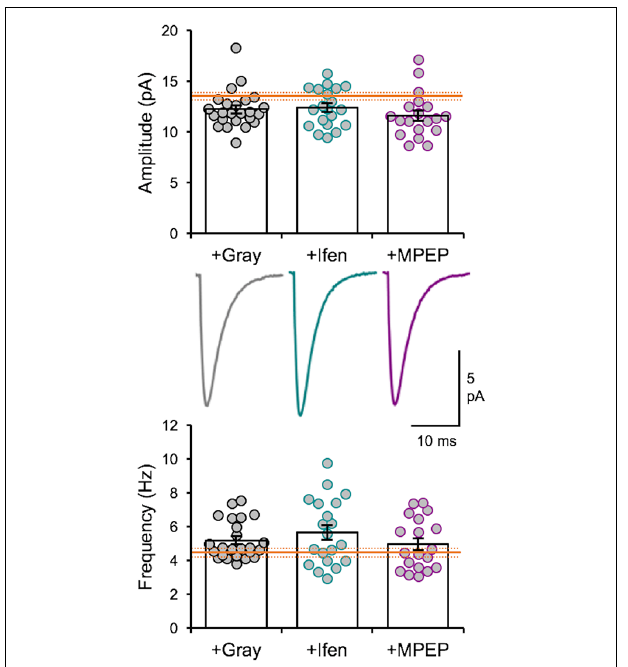
FIGURE 6 | The same naturalistic pattern stimulation yields distinct synaptic changes dependent on prior visual experience. (A) Example current-clamp recording traces recorded from V1 L2/3 neurons while stimulating L4 with +Gray spike train in slices obtained from NR (left) and LE (right) mice. Stimulation intensity used produced subthreshold EPSPs. (B) No difference in the average amplitude of mEPSCs recorded from NR slices stimulated with the +Gray activity when compared to unstimulated NR slices. Left: average mEPSC amplitudes of individual neurons are shown as circles and mean ± S.E.M are shown as bars (NR = 12.32 ± 0.42 pA, n = 22; NR+Gray = 11.7 ± 0.44 pA, n = 17; unpaired t -test: t = 1.003, p = 0.3222). n.s.: not statistically significant. Middle: average mEPSC traces. Right: average mEPSC frequency comparison (NR = 6.26 ± 0.43 Hz, NR+Gray stim = 5.24 ± 0.43 Hz, unpaired t -test, t = 1.643, p = 0.1088). n.s.: not statistically significant. (C) A significant increase in average amplitude of mEPSC recorded from LE slices stimulated with the +Gray activity when compared to unstimulated LE slices (LE). Left: average mEPSC amplitudes of individual neurons are shown as circles and mean ± S.E.M are shown as bars (LE = 11.81 ± 0.40 pA, n = 17; LE+Gray = 13.15 ± 0.44 pA, n = 23; unpaired t -test: t = 2.716, p = 0.0088). Middle: average mEPSC traces. Right: average mEPSC frequency comparison (LE = 4.70 ± 0.45 Hz, LE+Gray = 6.02 ± 0.43 Hz; unpaired t -test, t = 2.084 * p =